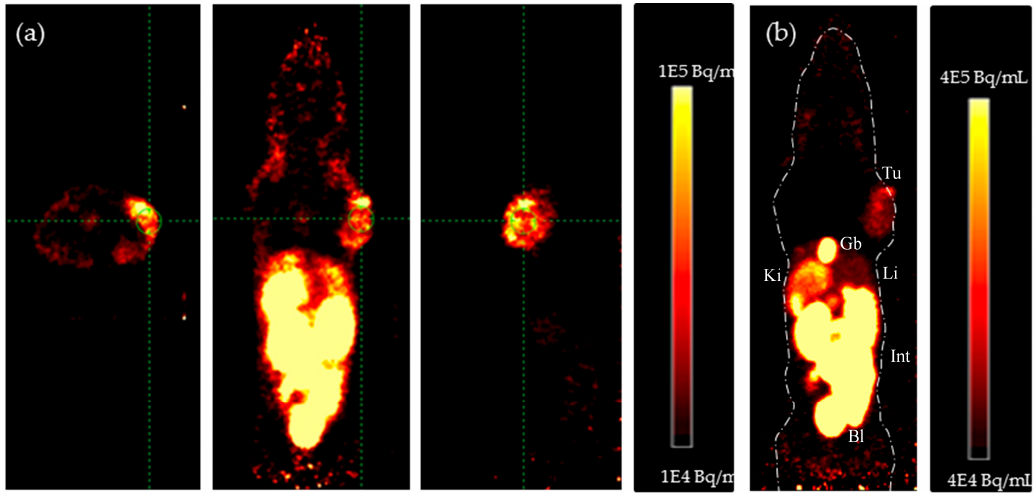
Figure 5. 18 F-Ala-folate. PET images of a KB-tumor bearing mouse. Static scan over 10 min 50 min p.i. ( a ) representative transverse, coronal and sagittal plane with a green crosshair pointing at KB-tumor and ( b ) Maximum intensity projection. Tu = KB-tumor, Gb = gallbladder, Li = liver, Ki = kidney, Int = intestines, Bl = bladder.